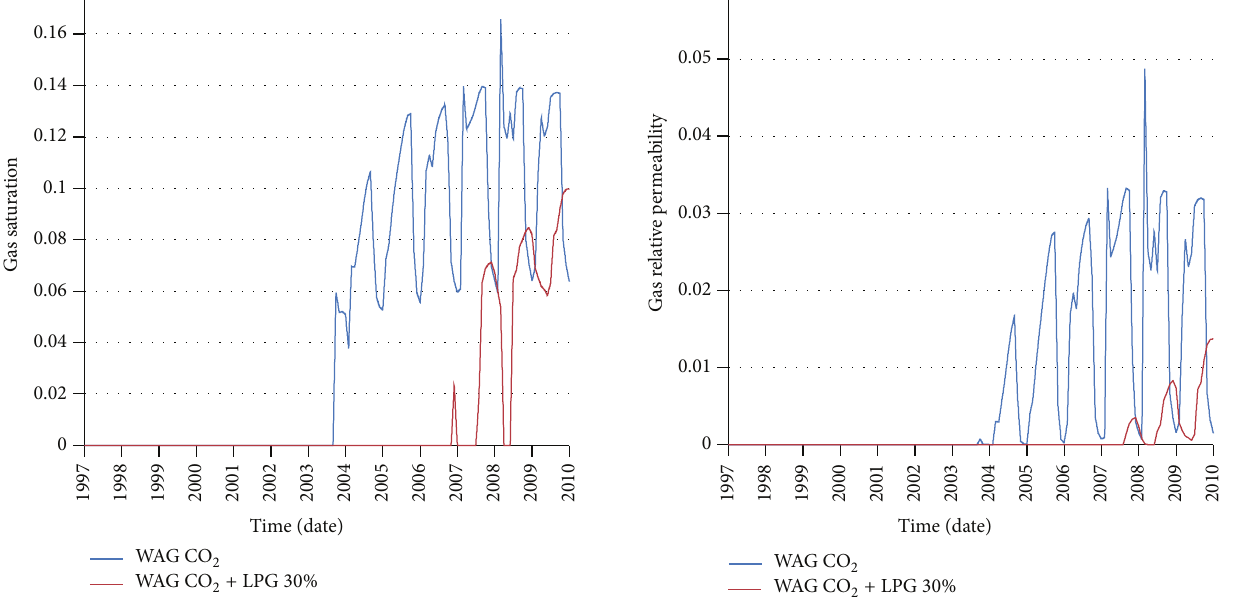
Figure 8: Gas relative permeability with LPG mole fraction of injection gas near production well for oil-wet condition.